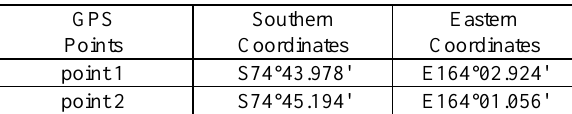
Table 1. GPS end points main runway